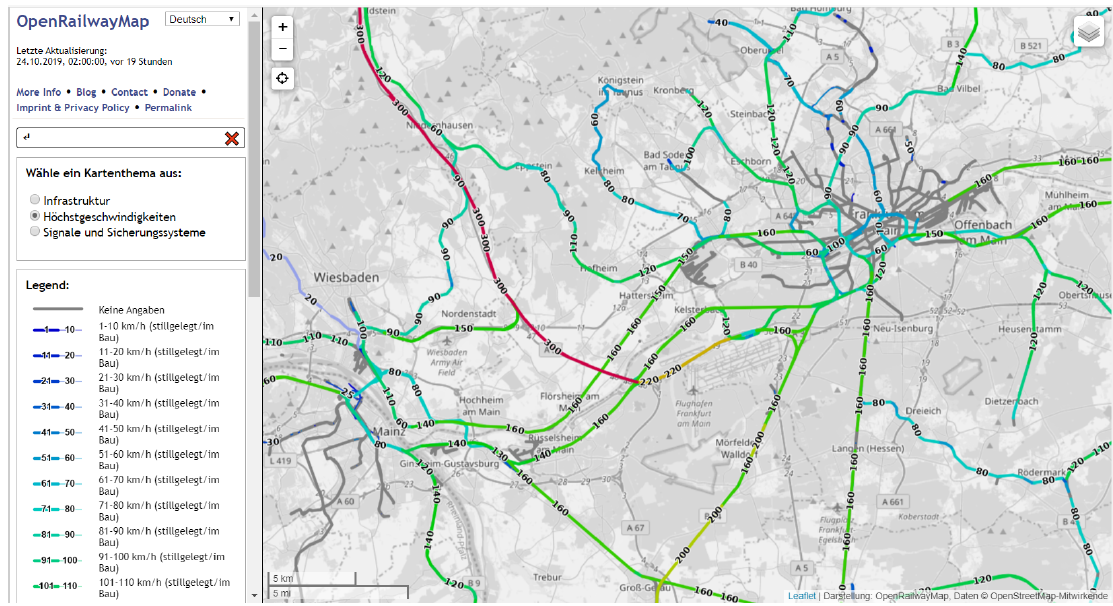
Figure 1. Thematic Map: OpenRailwayMap showing maximum speeds of railway lines in Germany. Here, a thematic map layer of max speeds is overlaying the general background of OpenStreetMap. Clearly, the focus of this map is to show the maximum speeds of railway lines. Therefore other details of the map except for the existence and completeness of the railway network are less